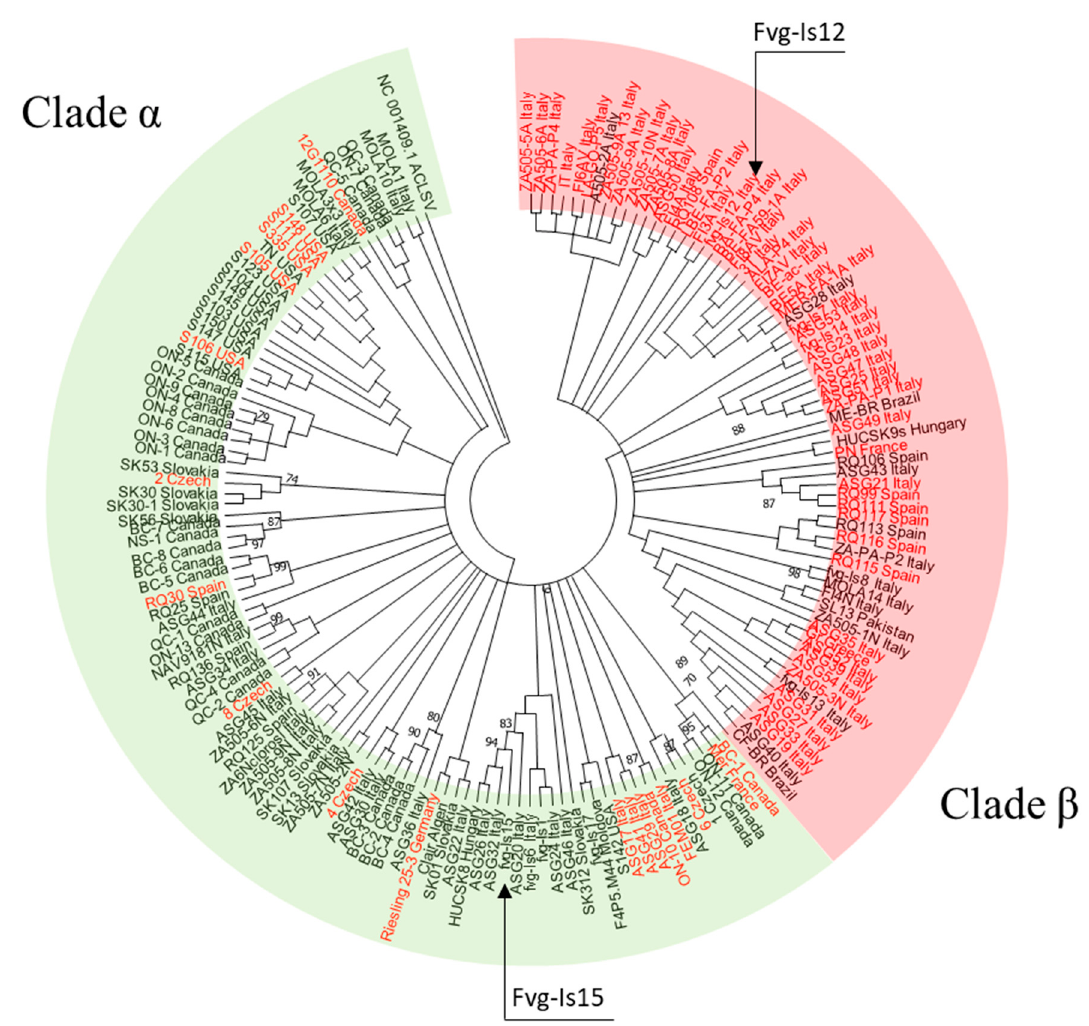
Figure 4. Phylogenetic relationships between 168 GPGV isolates regarding the MP/CP interregional sequence. This rooted neighbor joining tree was constructed with MEGA-X using a bootstrap value of 1000 and using apple chlorotic leaf spot virus as the outgroup. Nodes with higher than 70% bootstrap consensus are annotated. GPGV isolates collected from symptomatic grapevines are written in red. The green-shaded area indicates clade α , and the red-shaded area indicates clade β . A circular tree was selected instead of the traditional rectangular tree due to the high number of isolates.